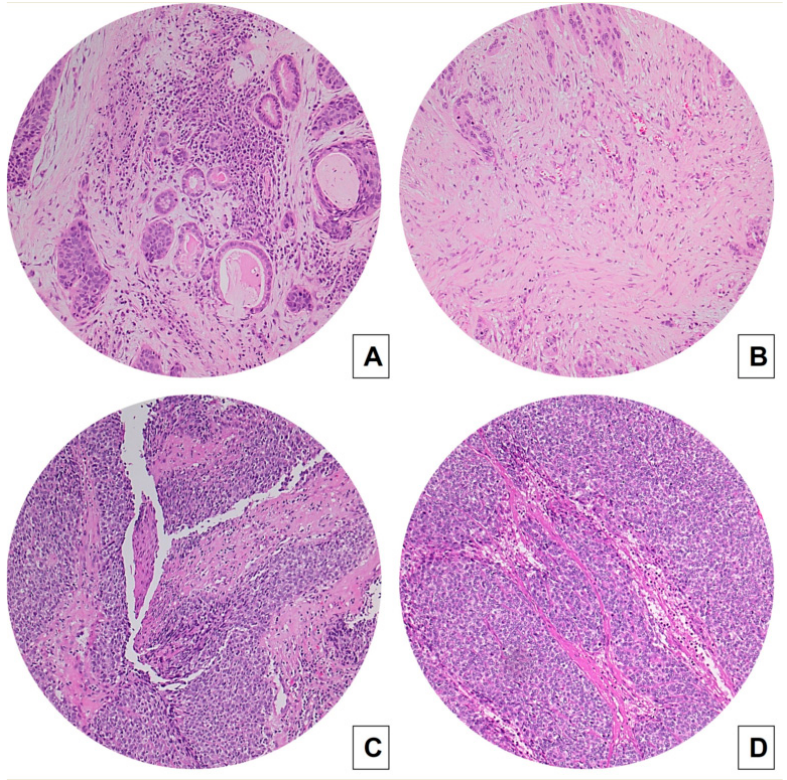
Figure 1. Concordance between TSR measured on biopsies ( A , C ) and on matched surgical specimens (B,D) in conventional SCC ( A , B ) and BSCCs ( C , D ) (hematoxylin and eosin H&E stained slides, original magnification 100×). Laryngeal BSCC ( C , D ) shows a high TSR (stroma-poor case), whereas conventional SCC ( A , B ) displays a low TSR (stroma-rich case).